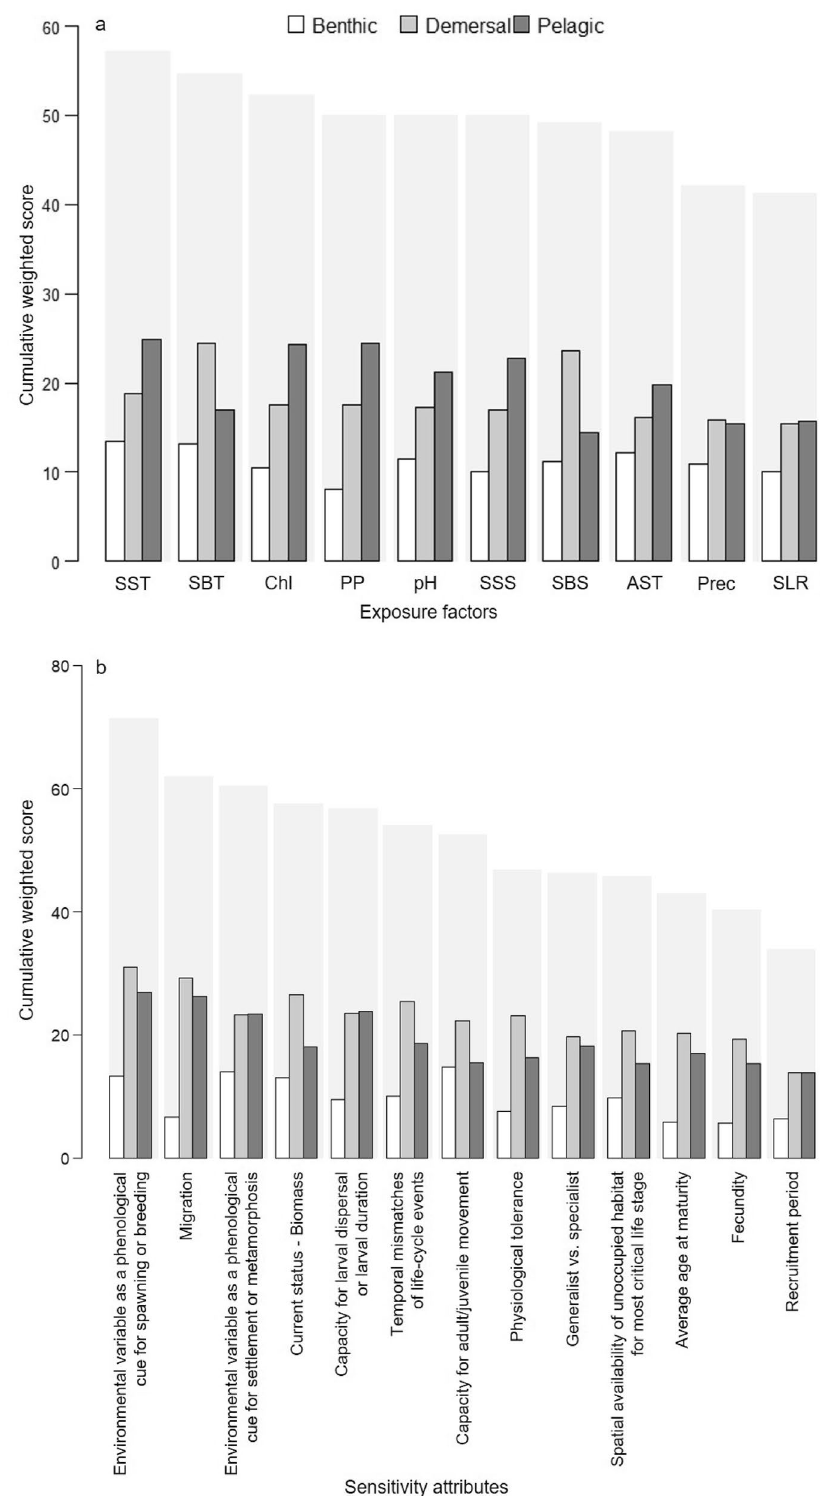
Figure 3. Cumulative weighted score of ( a ) climate exposure factors and ( b ) sensitivity attributes. Thin bars correspond to the cumulative weighted score of species groups. Thick light shaded bars correspond to the total cumulative weighted score. SST: Sea surface temperature; SBT: Sea bottom temperature; Chl: Chlorophyll concentration; PP: Primary productivity; pH: as a proxy for ocean acidification; SSS: Sea surface salinity; SBS: Sea bottom salinity; AST: Air surface temperature; Prec: Precipitation; SLR: Sea level